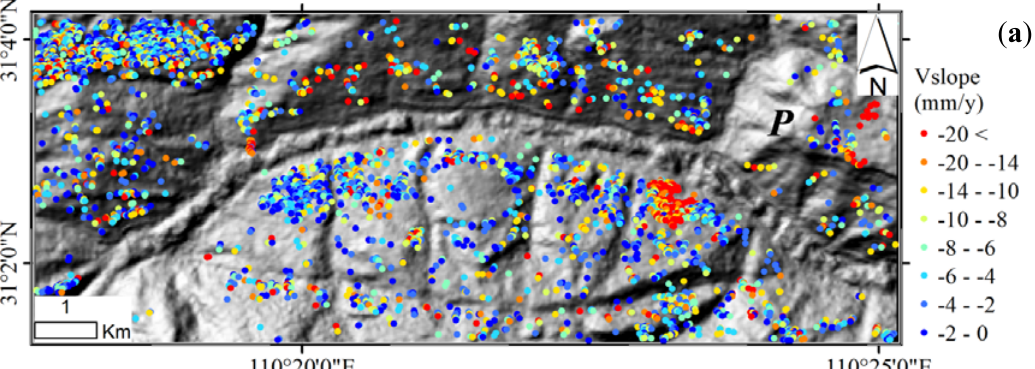
Figure 5. Down-slope mean deformation velocities at PS points for the three Synthetic-Aperture Radar interferometry (InSAR) data stacks: ( a ) Advanced Land Observing Satellite (ALOS) Phased Array L-band Synthetic Aperture Radar (PALSAR), ( b ) Environmental Satellite (ENVISAT) Advanced Synthetic Aperture Radar (ASAR) ascending, and ( c ) ENVISAT ASAR